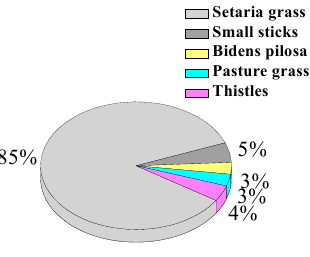
Figure 7. Percentages of different types of vegetable matter (%).